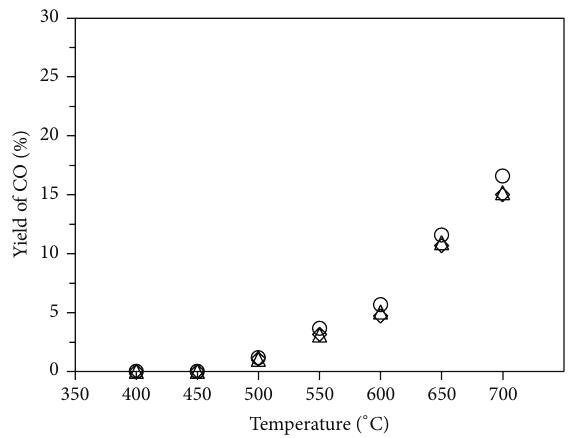
= 𝑃 = 1 kPa, H 2 CO 2